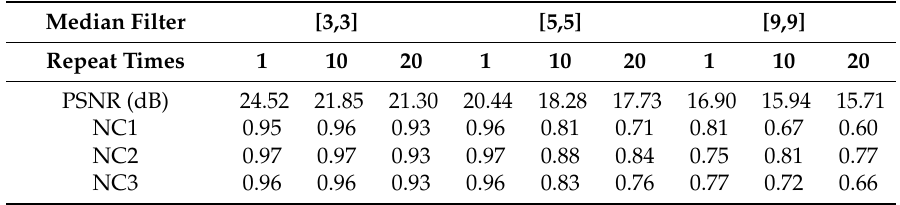
Figure 17. Under Median Filter attacks: (a) Median Filter[3 x 3] with 10 repetitions; (b) the extracted watermark 1 under median filter [3,3] with 10 repetitions; (c) the extracted watermark 2 under median filter[3,3] with 10 repetitions; (d) the extracted watermark 3 under median filter[3,3] with 10 repetitions; (e) Median Filter[9,9] Repeat times 10; (f) the extracted watermark 1 under median filter[9,9] with 10 repetitions; (g) the extracted watermark 2 under median filter[9,9] with 10 repetitions; (h) the extracted watermark 3 under median filter[9,9] with 10 repetitions. Table 5. Data of Median Filter attacks.